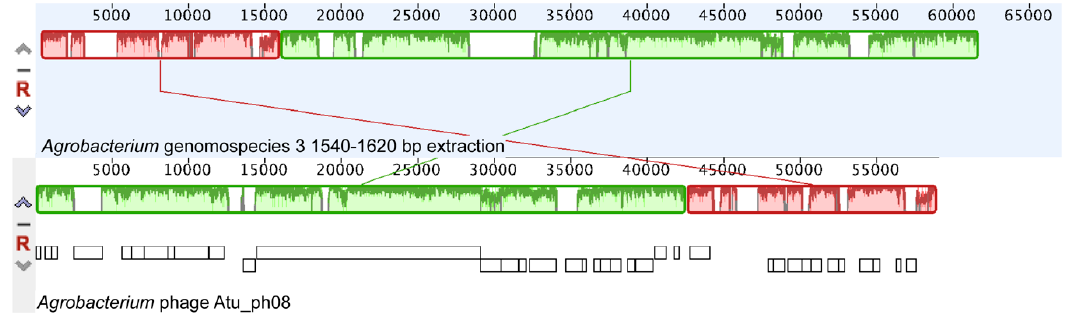
Figure 5. Mauve genome alignment of the 1540–1610 kbp region of Agrobacterium genomospecies 3 and Atu_ph08.